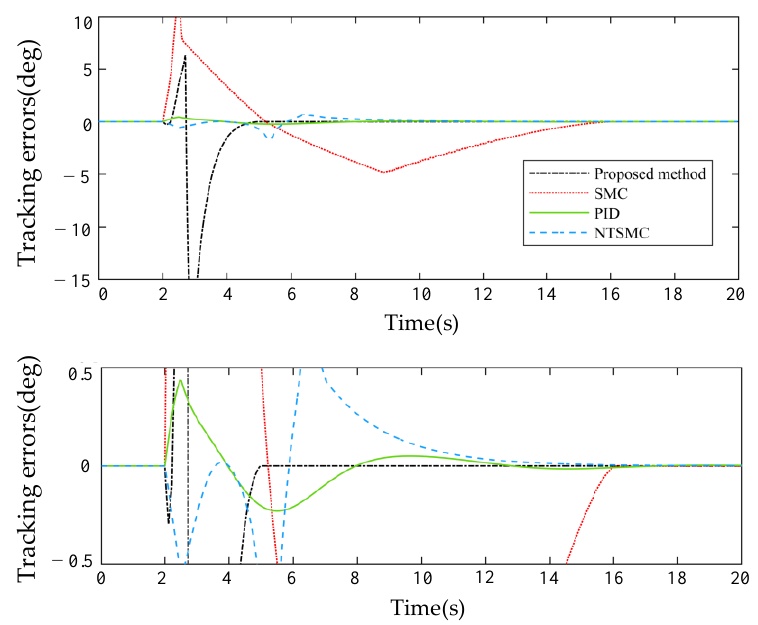
Figure 7. Attitude tracking error for different controllers of joint 2.